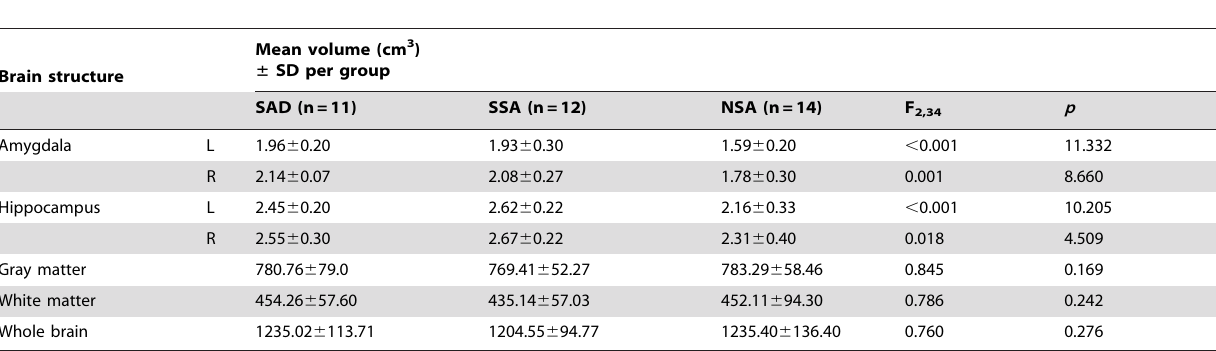
Table 2. Mean volumes (cm 3 ) of right and left amygdala, hippocampus, white and gray matter, and whole brain in subjects with social anxiety (SA), subthreshold social anxiety (SSA) and non-anxious healthy controls (NSA).